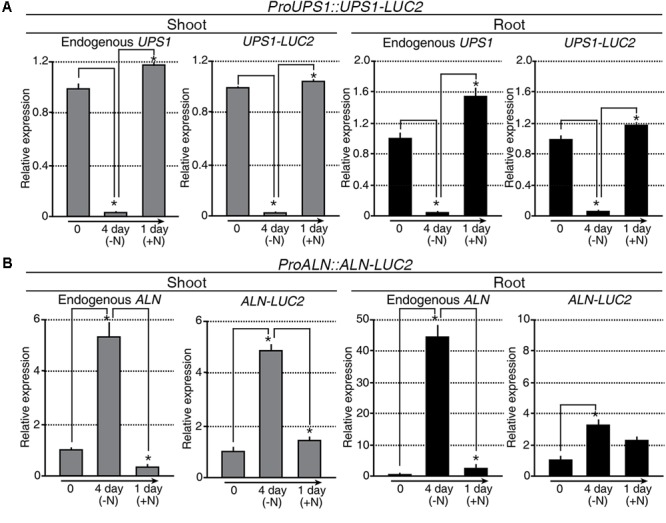
Transcriptional regulation of proALN::ALN-LUC2 and proUPS1::UPS1-LUC2 is similar to the expression of endogenous genes modulated by differences in N status. qRT-PCR analysis of proUPS1::UPS1-LUC2
(A) and proALN::ALN-LUC2
(B) expression in shoots and roots following N starvation and re-application treatments. UPS1-LUC2 and ALN-LUC2 correspond to transcripts derived from proUPS1::UPS1-LUC2 and proALN::ALN-LUC2, respectively. OsUBI1 expression was used as an internal control. Data shown are the mean + SD of two biological and two technical replicates. Asterisks indicate significant differences based on a 95% confidence interval by a Student’s t-test.